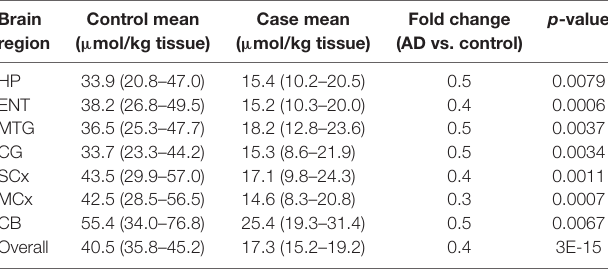
TABLE 1 | Level of pantothenate in post-mortem human brain in Alzheimer’s disease and age-matched controls. Brain Control mean Case mean Fold